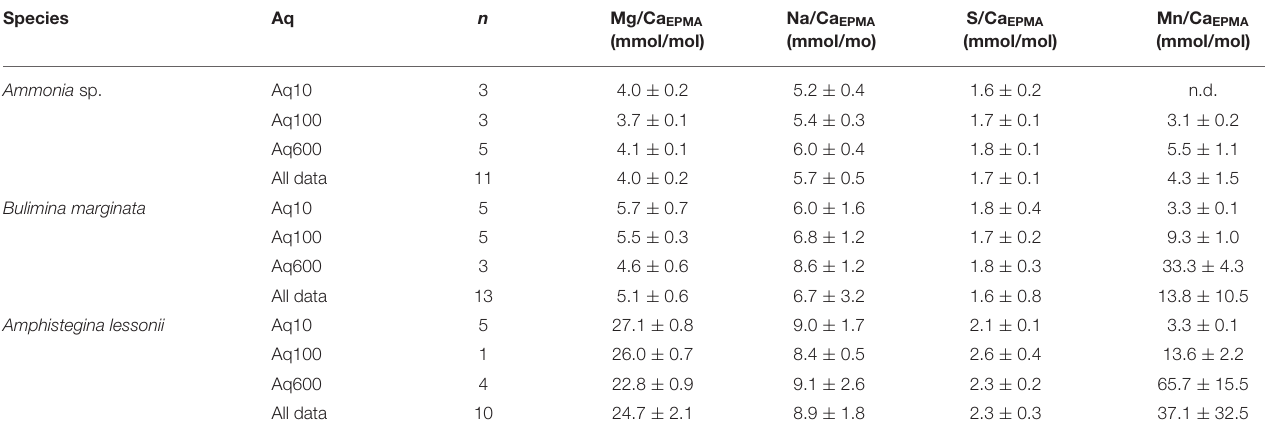
Na/Ca EPMA S/Ca EPMA Mn/Ca EPMA (mmol/mol) (mmol/mo) (mmol/mol) (mmol/mol)